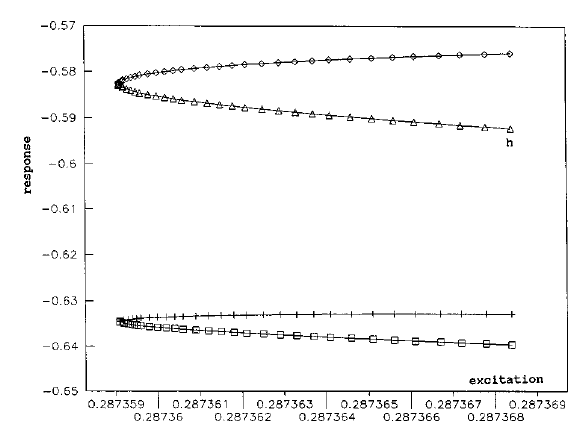
Fig. 2. Bifurcation diagram (1).